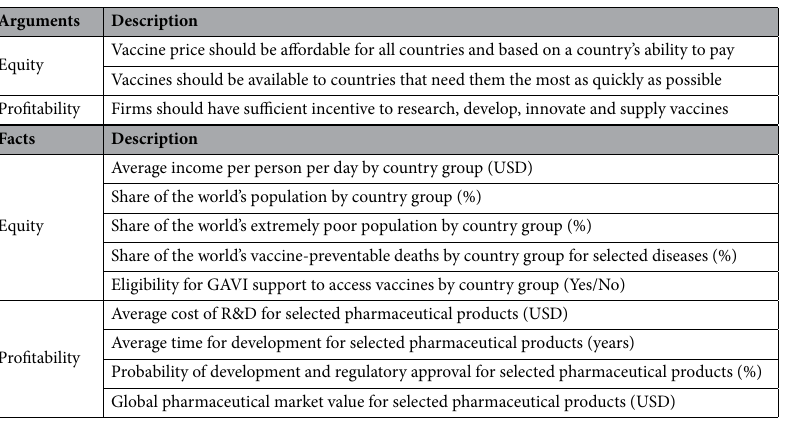
Table 1. Information provided in the Arguments condition and Facts condition. The full text of each fact and each argument is included in the Supplementary information section. Factual information was provided to participants in tables of statistics. Selected diseases used in “Share of the world’s vaccine-preventable deaths by country group (%)” were: Tuberculosis, Whooping cough, Tetanus, Measles, Varicella and herpes zoster, Acute hepatitis A, Acute hepatitis B, Typhoid fever, Pneumococcal meningitis, H influenzae type B meningitis, Meningococcal meningitis, Diphtheria, Dengue, and Yellow fever. Selected pharmaceutical products for profitability-related facts were: vaccines, cardiovascular disease drugs and cancer